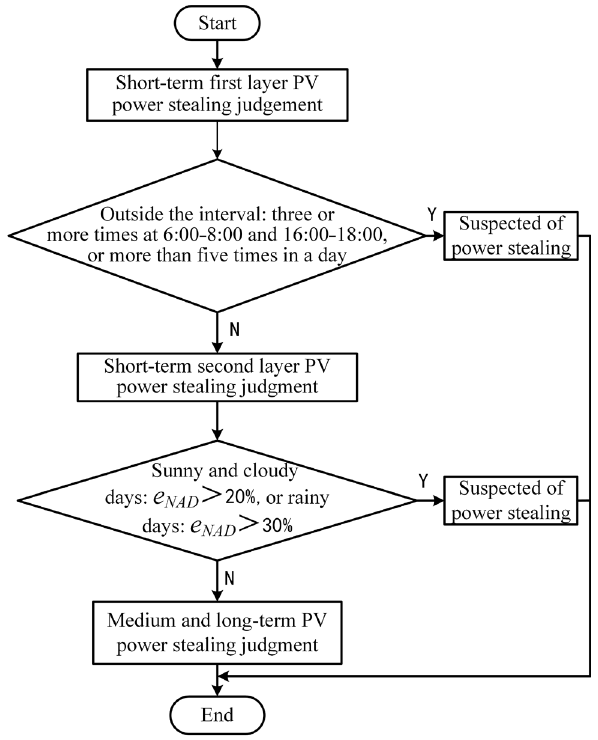
Figure 4. Flow chart of overall power-stealing identification.